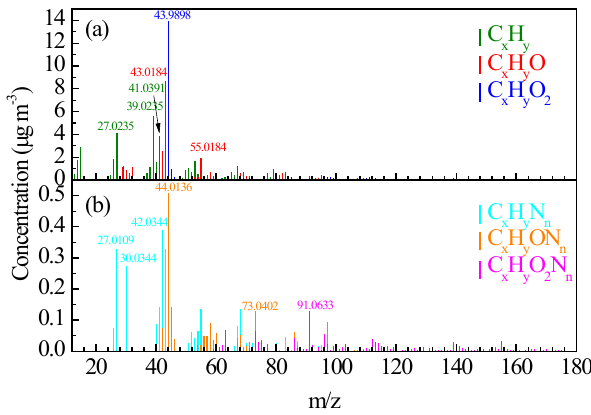
Figure 1. Typical HR-ToF-AMS spectra of (a) non-N-containing fragments and (b) N-containing fragments in SOA formed by O 3 oxidation of α -pinene in the presence of 40.8ppbv NH 3 (Exp. P6).